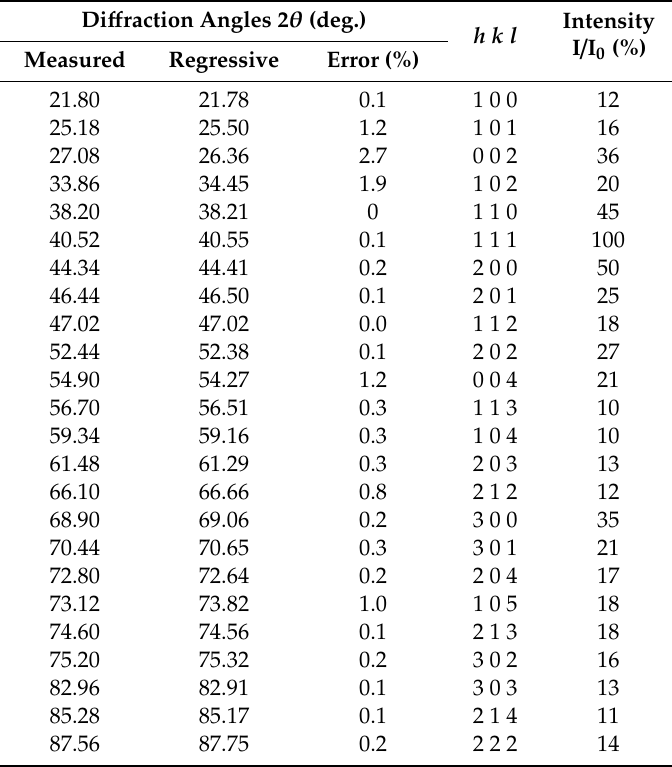
Table 2. The X-ray di ff raction (XRD) data of Cu 2 SnTi 3 using Cu K α radiation ( λ = 0.1541 nm). Di ff raction Angles 2 θ